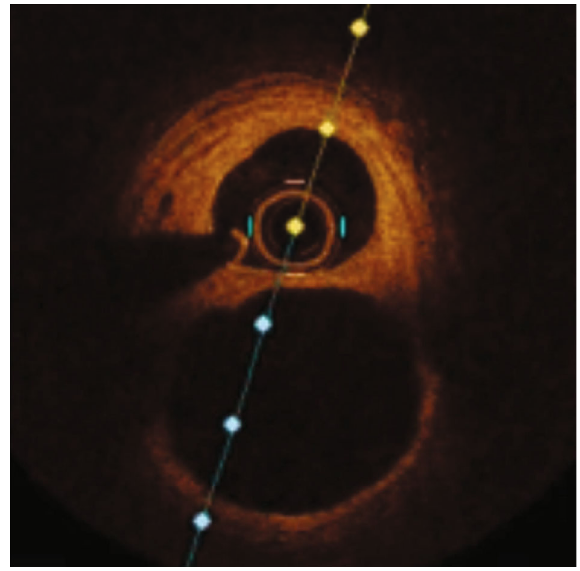
Figure 2: Optical coherence tomography (OCT) of right coronary artery (RCA) showing multiple channels.